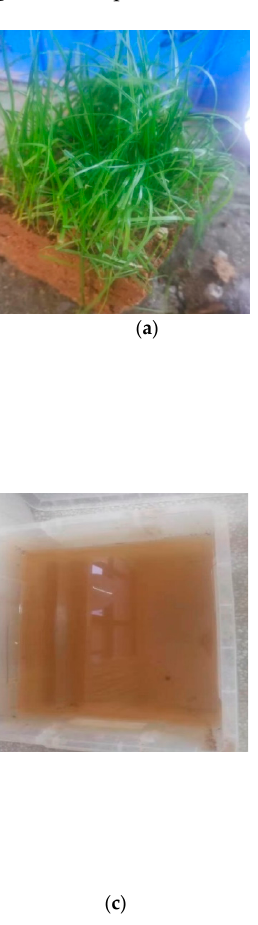
Figure 5. SRS test configuration: ( a ) VC sample with plants; ( b ) test process; ( c ) washed outflows.